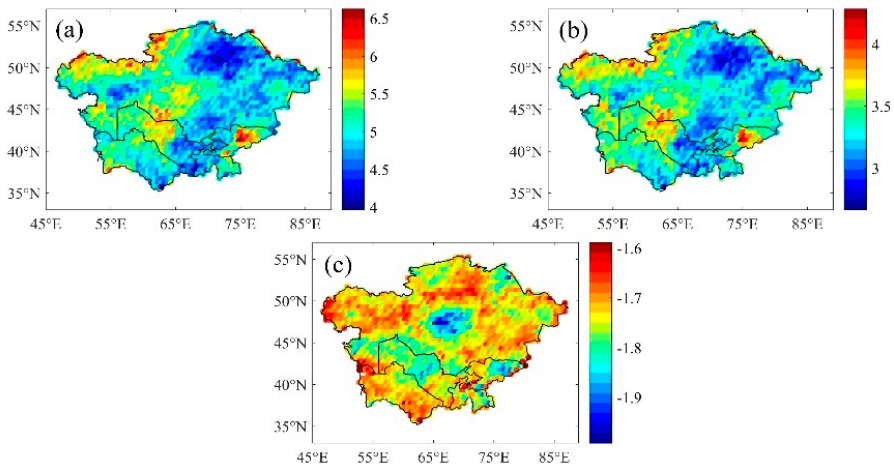
Figure 5. The spatial distribution of drought variables based on SPEI-3 from 1961 to 2017: ( a ) Ds; ( b ) Dd; ( c ) Dp.